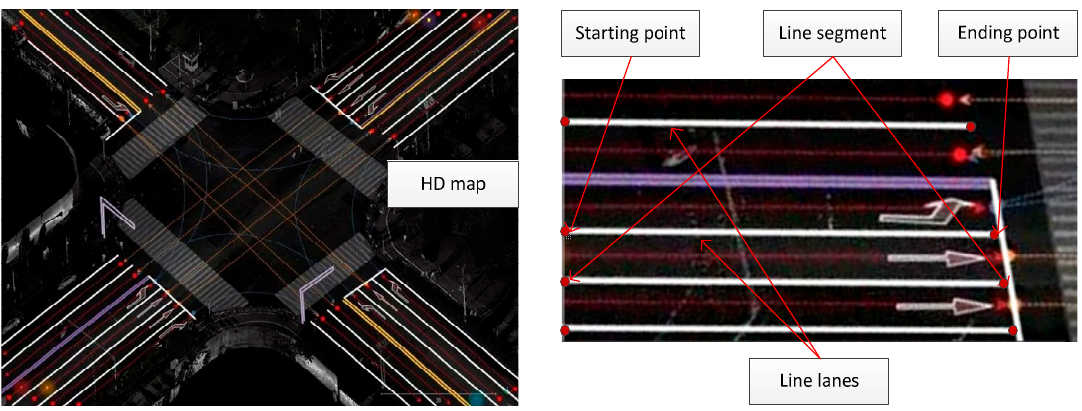
Figure 2. HD map demonstration and the representation of lane line with line segments.